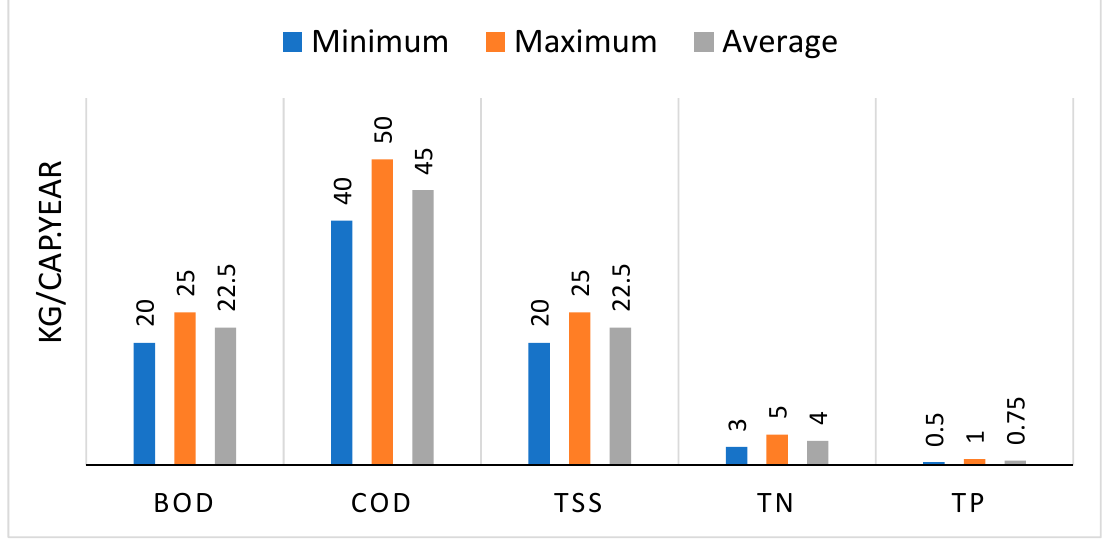
Figure 2. Generation rates for BOD, COD, TSS, TN, and TP pollutants in Egypt [52].